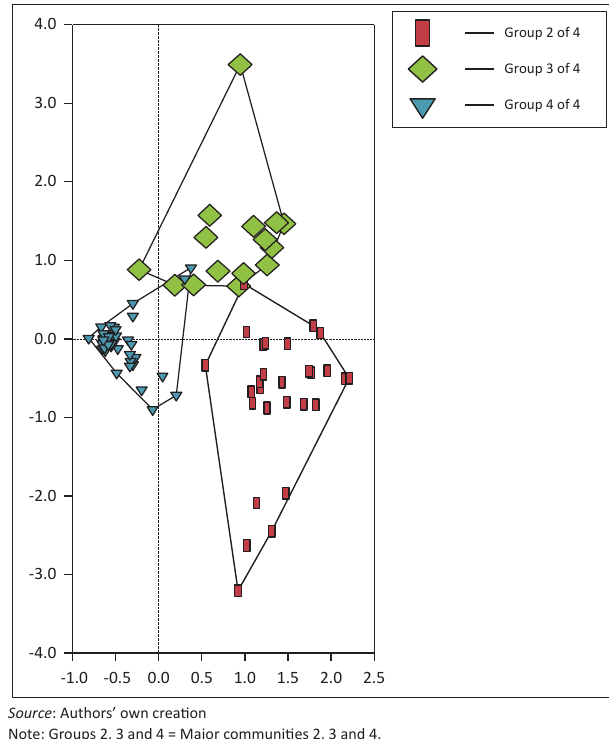
FIGURE 5: Correspondence analysis with wetlands (Group 1) removed to show more clearly the gradients typifying Groups 2, 3 and